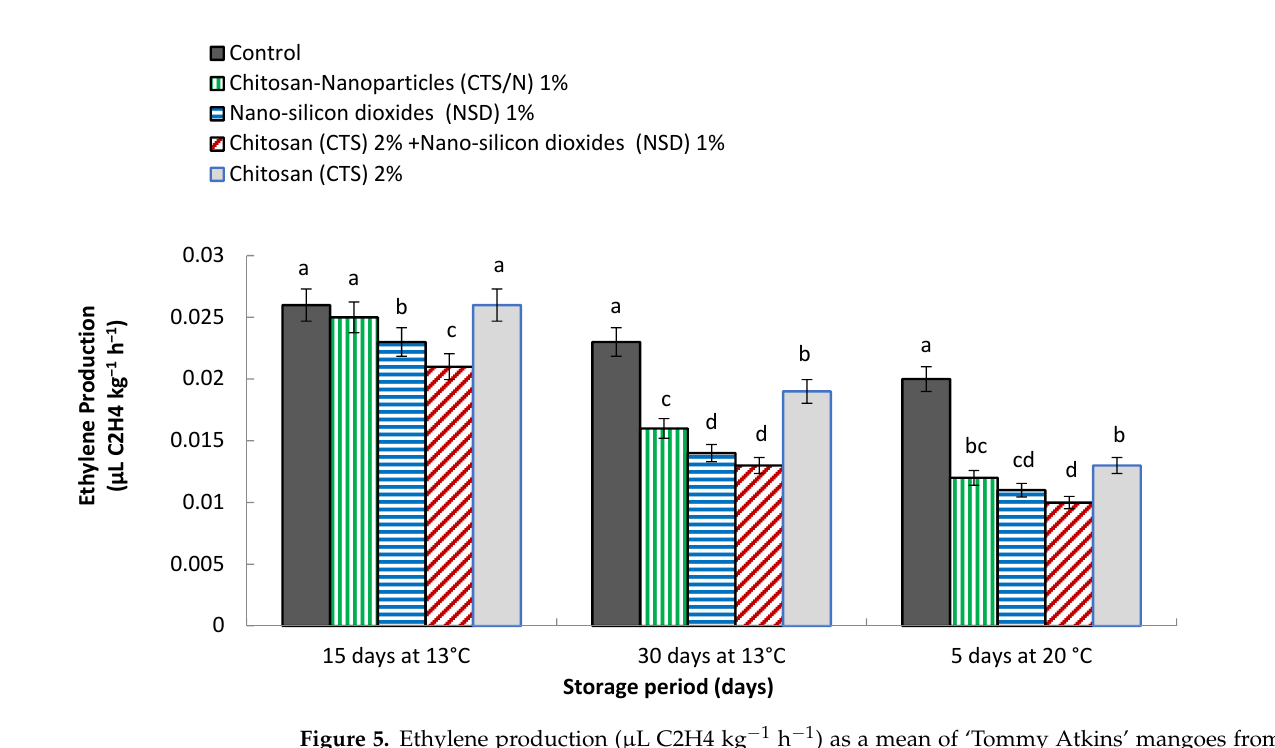
Figure 4. Fruit firmness (N/cm) as a mean of ‘Tommy Atkins’ mangoes from two seasons, stored at 13 ± 1 °C and 90–95% RH for 30 days. Afterward, the fruits were stored at 20 ± 2 °C and 70–75% RH for 5 days as the marketing period. Vertical bars indicate the standard error (SE) of the mean ( n = 5). The superscript letters followed by the same letters are not significantly different according to Dun- can’s multiple range test at 0.05 level.